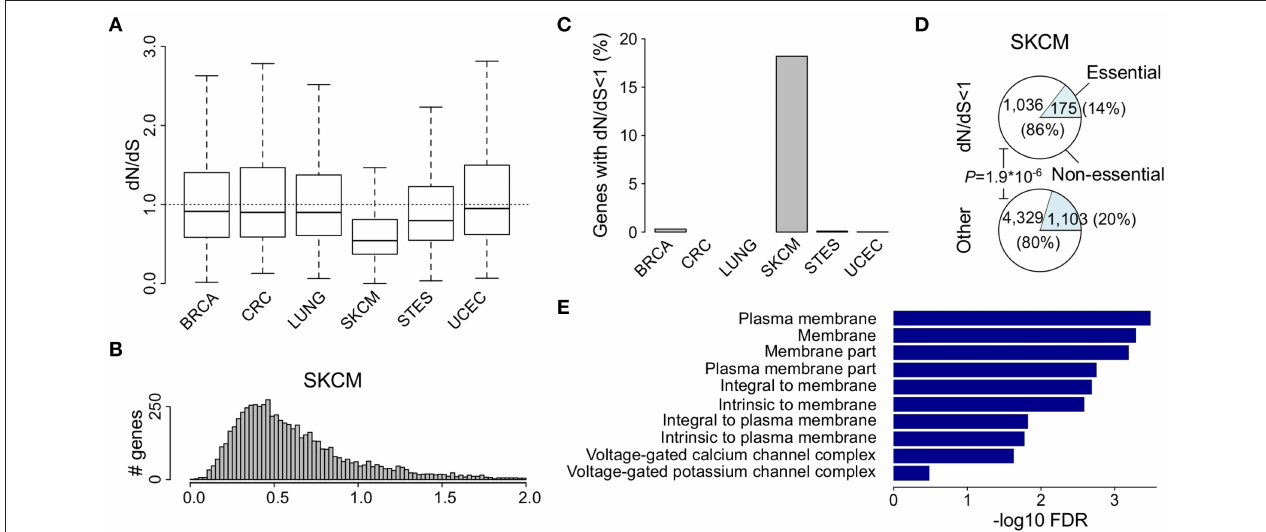
FIGURE 1 | Low dN/dS values in malignant melanoma do not indicate gene essentiality. (A) Comparison of dN/dS values between the 6 cancer types under analysis. (B) Histogram of dN/dS values in malignant melanoma. (C) Proportion of analyzed genes that have dN/dS significantly below 1 at 5% FDR. (D) Pie charts show the proportion of indicated genes in malignant melanoma that are known to be essential. (E) GO cellular component gene set enrichment analysis for all genes that have dN/dS < 1 (5% FDR) in malignant melanoma. Cellular components are ranked on FDR values as indicated and only the 10 most significantly enriched components are shown. The ratio dN/dS was calculated using a basic uniform